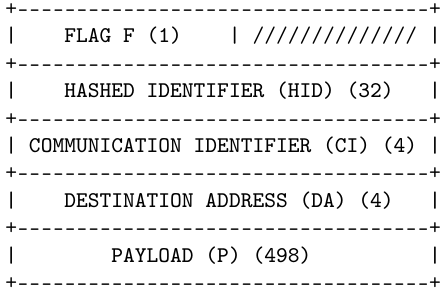
Figure 2. Structure of the